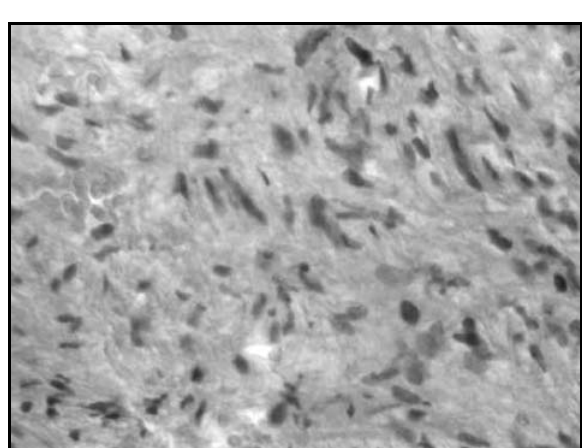
Figura 6 – Aspecto microscópico (HE,